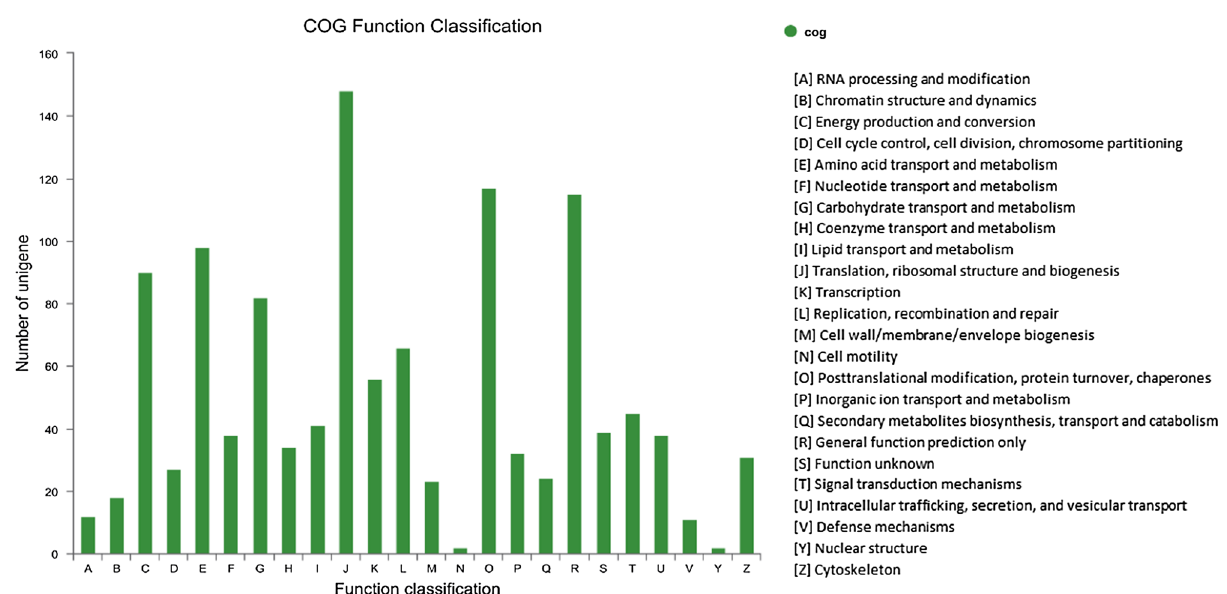
Figure 4. COG analysis of the unigene sequences of C. comatus . The Y-axis indicates the number of unigenes in a specific functional cluster. The X-axis indicates the function